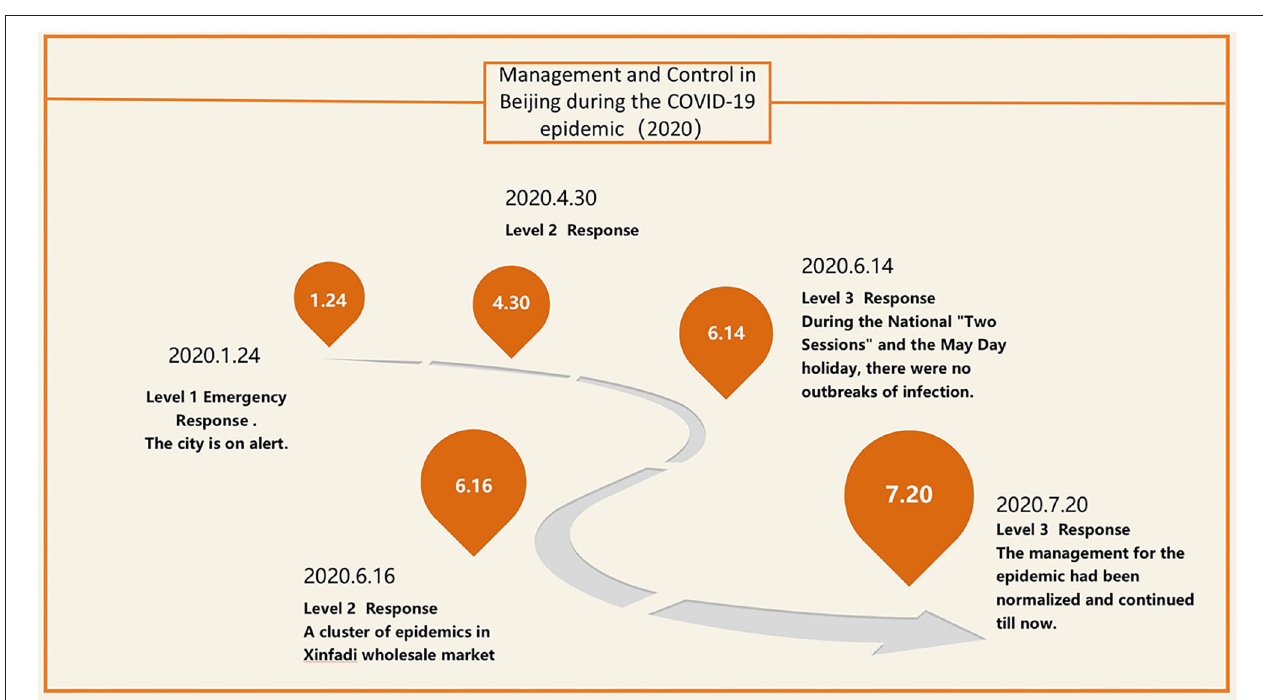
FIGURE 1 | Management and control in Beijing during the coronavirus disease 2019 (COVID-19) epidemic (2020).